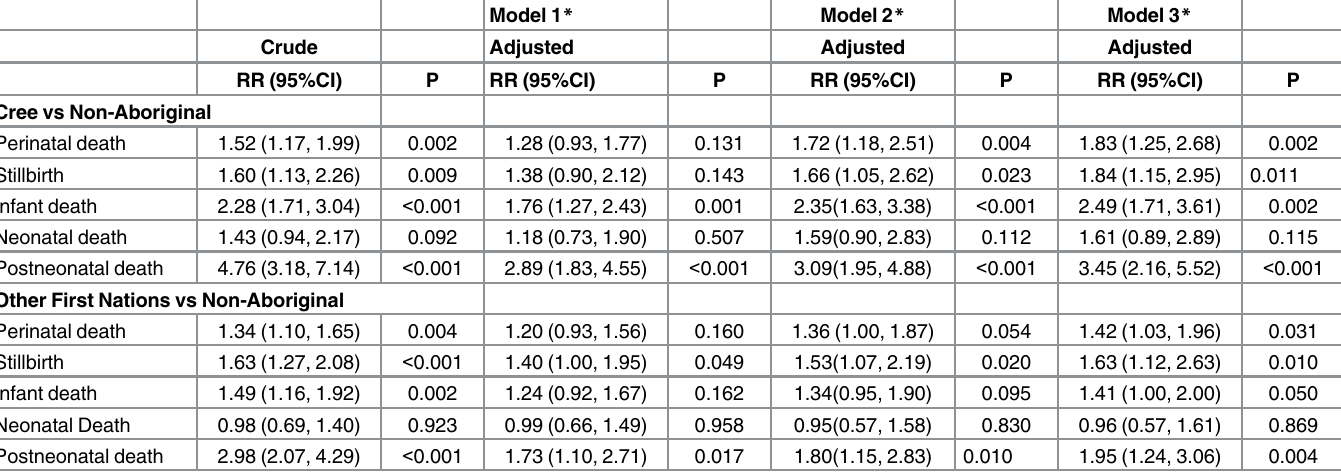
Table 3. Crude and adjusted RRs of perinatal and infant mortality comparing births in Cree, other First Nations vs. Non-Aboriginal communities, Quebec 1996 –